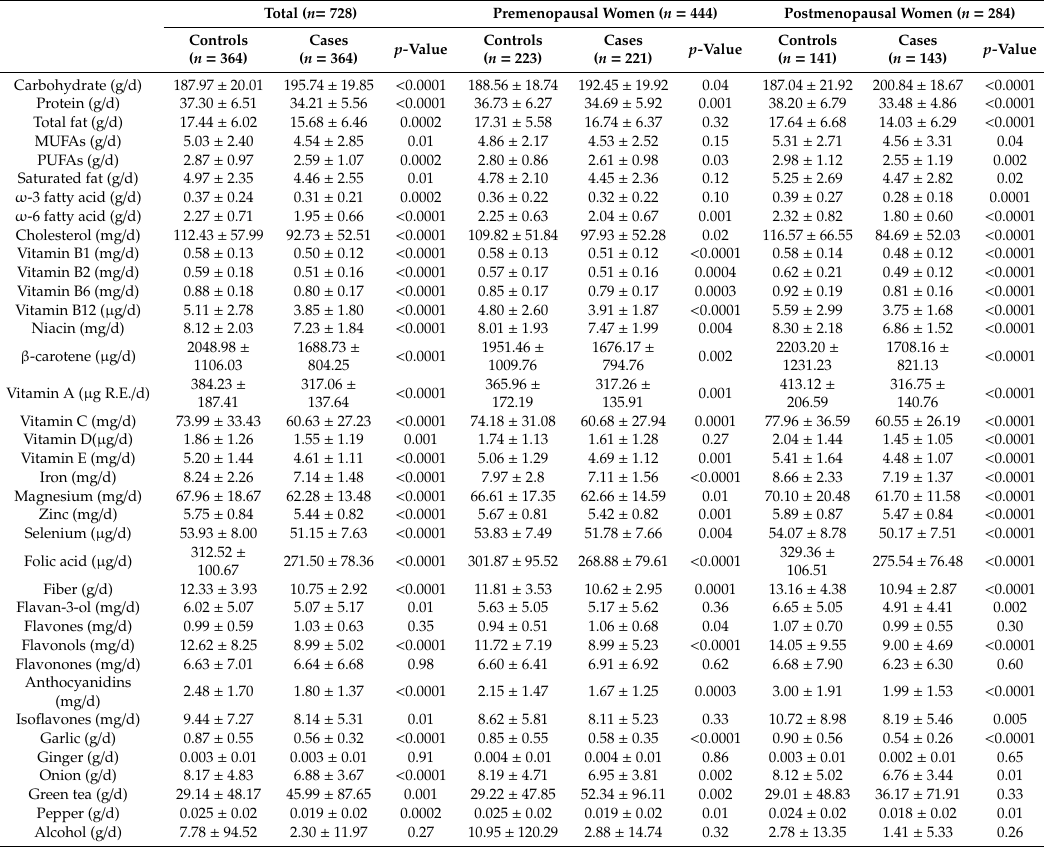
Table 2. Dietary Inflammatory Index (DII) component intake of the